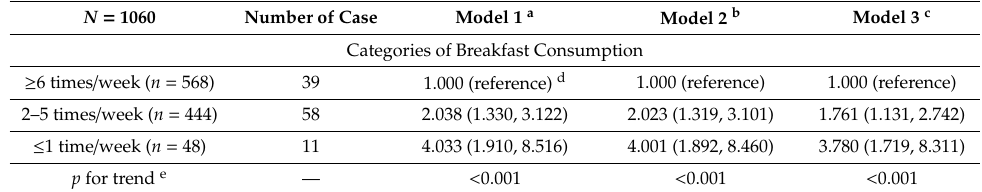
Table 2. Adjusted relationships between breakfast consumption frequency and the risk of depressive symptoms at baseline a .